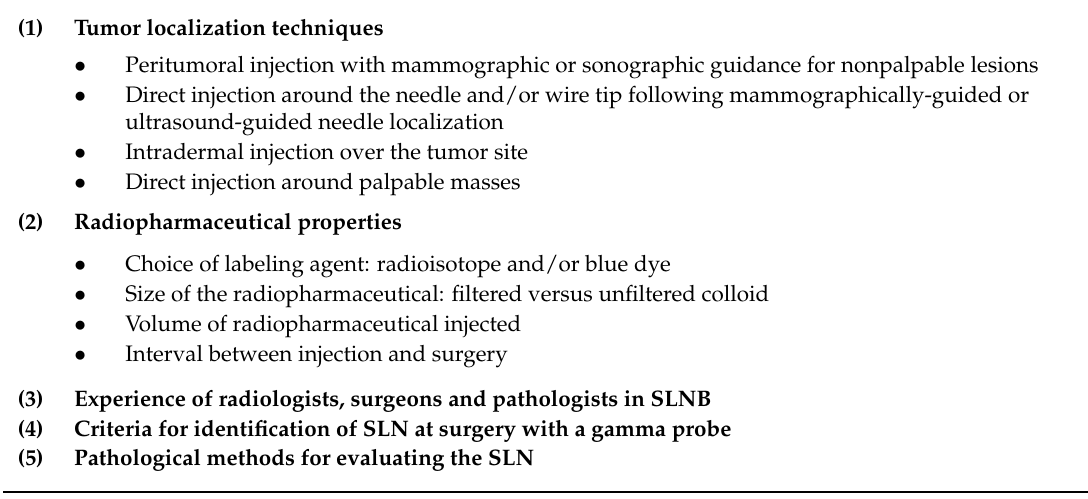
Table 1. Technical Factors in Sentinel Lymph Node